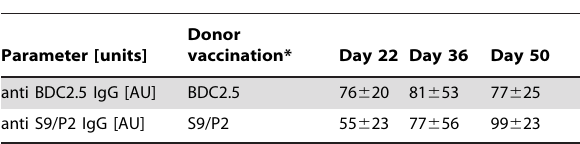
Table 4. Anti S9/P2 and anti BDC2.5 TscFv IgG in serum of BDC2.5 TCR tg recipients after transfer of B-cells from donors vaccinated with TscFv S9/P2 or BDC2.5.